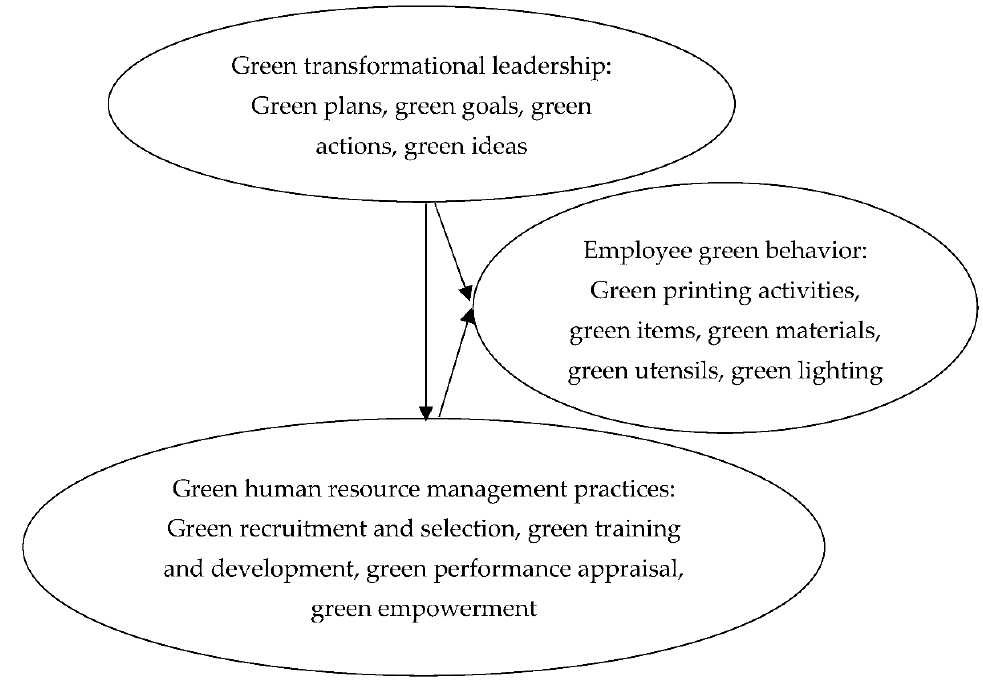
Figure 1. Research framework.